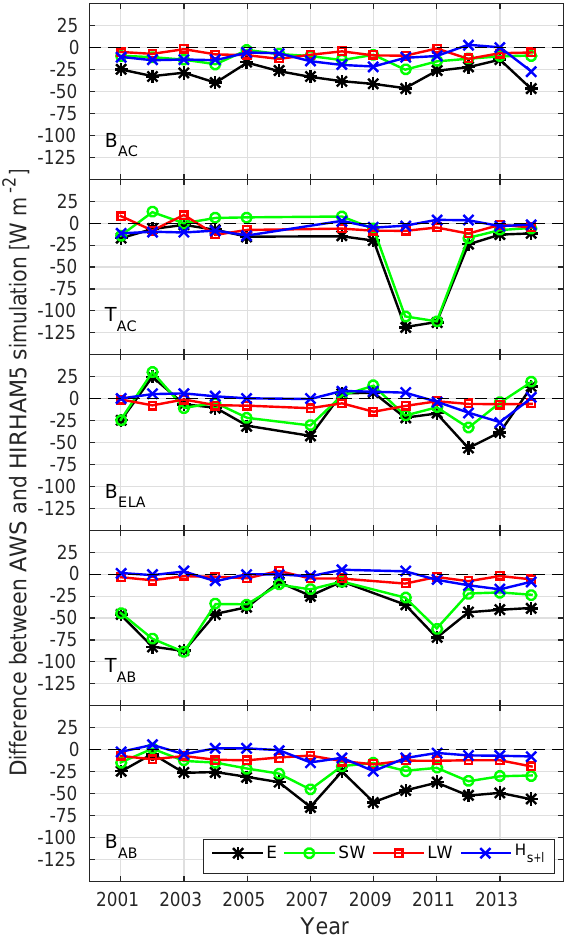
Figure 6. The average summer (April–October) bias of each energy balance component for the measurement period at each AWS site. The large deviation in the SW radiation at the Tunaárjökull sites in 2010–2011 is due to deposition of ash on the glacier during the 2010 Eyjafjallajökull and 2011 Grímsvötn eruptions.